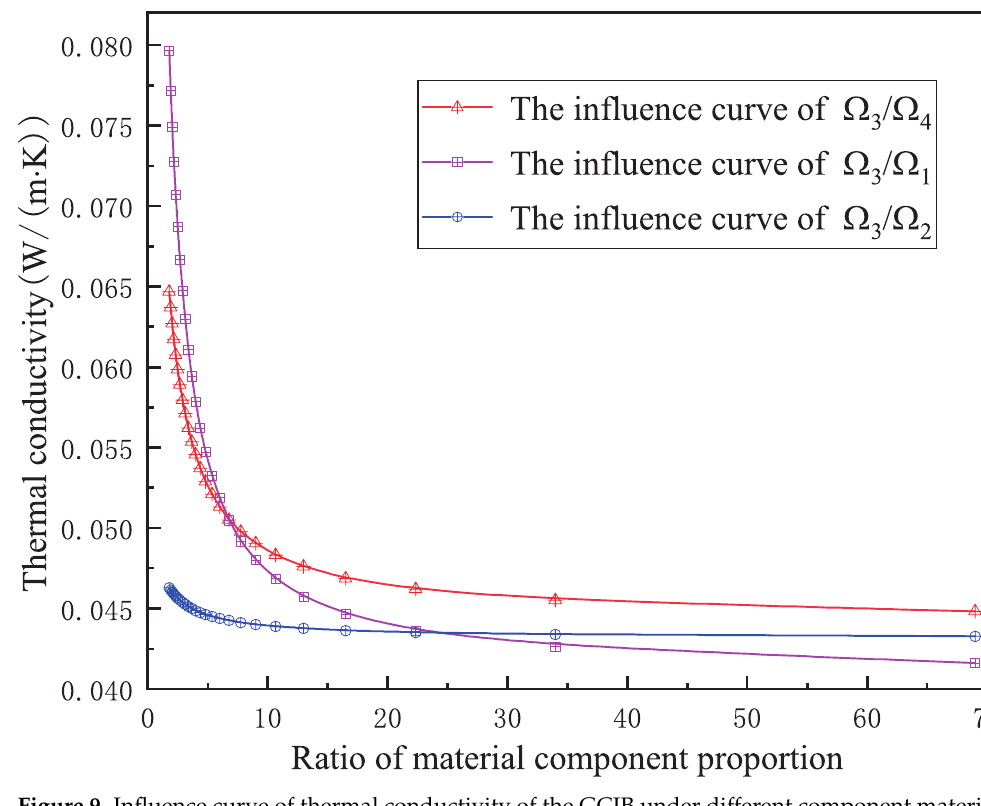
Figure 9. Influence curve of thermal conductivity of the GCIB under different component material